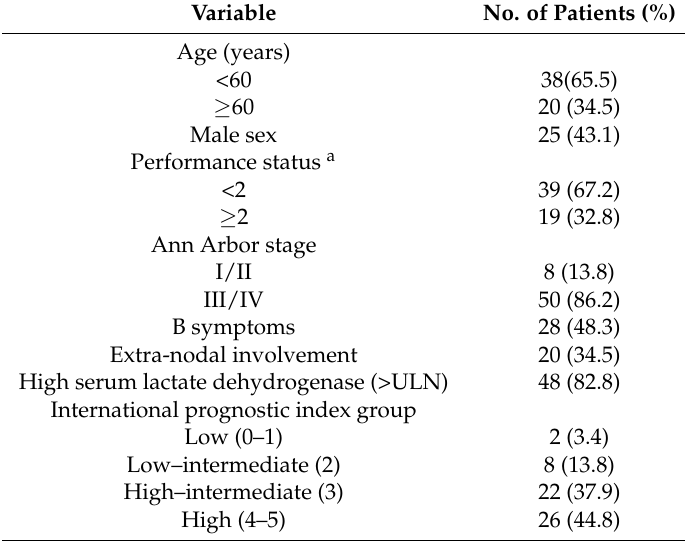
Table 1. Main clinical characteristics of 58 patients with diffuse large B-cell lymphoma